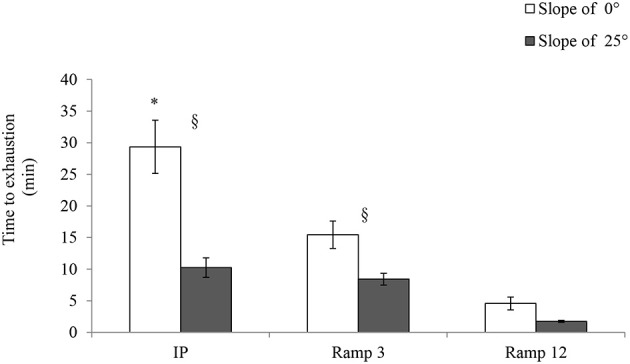
Time to exhaustion. IP, an incremental protocol with a starting speed of 10 m.min−1 and an increment of 3 m.min−1 every 3 min; Ramp3, a ramp protocol with a starting speed of 3 m.min−1 and an acceleration of 3 m.min−2 (0.05 m.min−1.s−1); Ramp12, a ramp protocol with a starting speed of 3 m.min−1 and an acceleration of 12 m.min−2 (0.2 m.min−1.s−1); §, a significant difference between 25 and 0° for the same protocol (p < 0.05); *, differs significantly from all other protocols (p < 0.05).